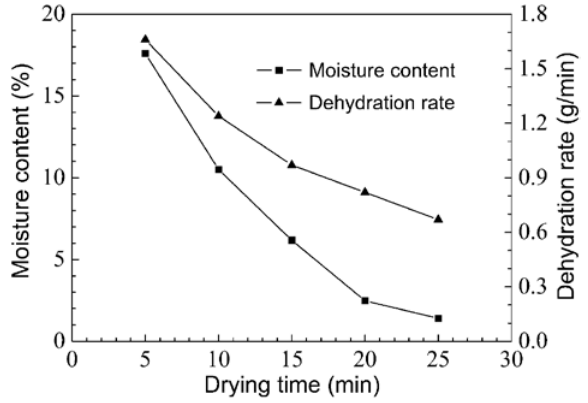
Figure 4: The effect of drying time on moisture content and dehy- drating rate of zinc oxide leach